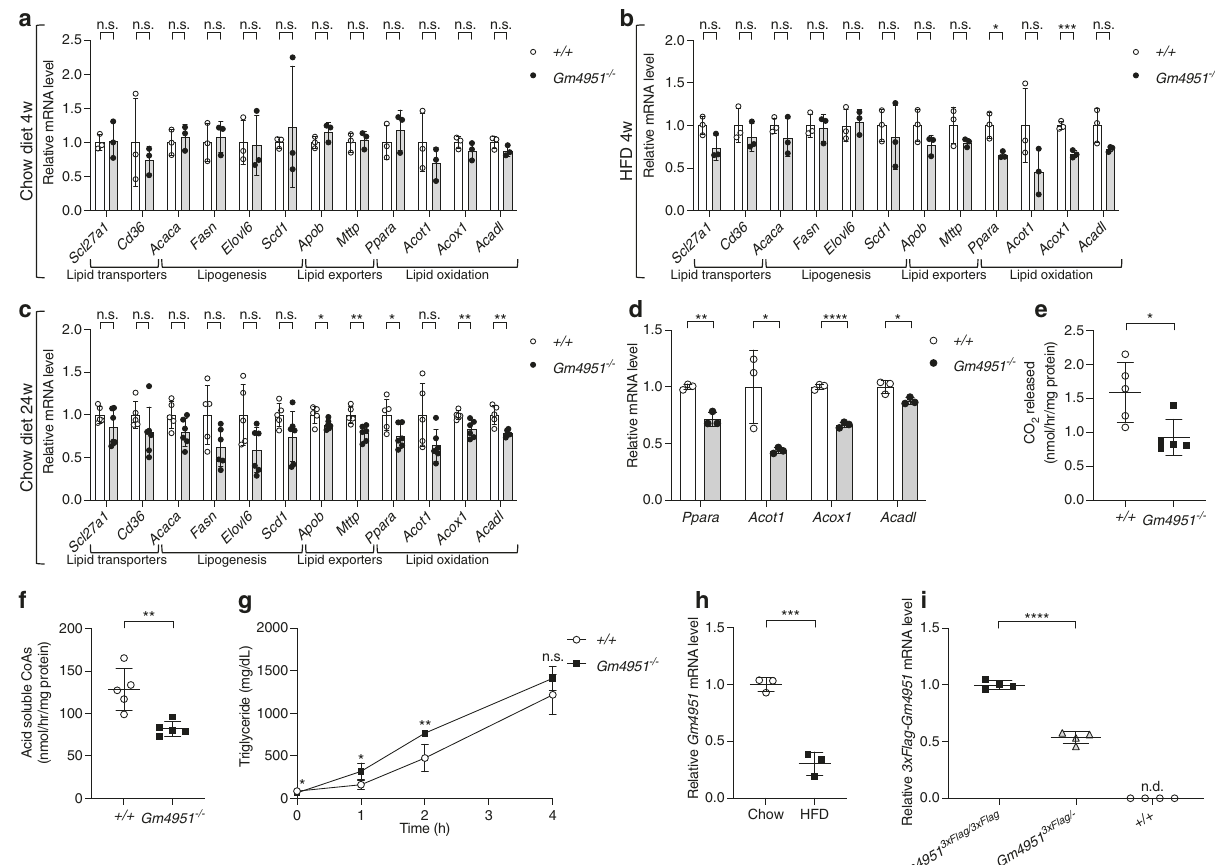
Fig. 5 GM4951 is involved in lipid oxidation and is downregulated by HFD feeding. a - c Relative mRNA level of different genes in the liver from WT and Gm4951 − / − mice on chow diet ( a ) and HFD ( b ) for four weeks ( n = 3 mice per genotype), and chow diet for 24 weeks ( c ) ( n = 5 mice per genotype). Levels were normalized to Polr2a mRNA and then to levels in WT mice. d Relative mRNA level of different genes in hepatocytes from WT and Gm4951 − / − mice after 0.5 mM OA for 24 h ( n = 3 mice per genotype). e , f CO 2 released ( e ) and acid soluble CoAs ( f ) from fatty acid oxidation experiment were measured with scintillation counting and normalized with total protein of liver lysates ( n = 5 mice per genotype). g The serum level of triglycerides at different time points after Triton WR-1399 injection in WT and Gm4951 − / − mice on HFD for 4 weeks ( n = 3 mice per genotype). h Relative mRNA level of Gm4951 in the liver from C57BL6/J mice on chow diet or HFD for 24 weeks ( n = 3 mice per genotype). Levels were normalized to Polr2a mRNA and then to levels in WT mice fed chow diet. i Relative mRNA level of 3xFlag-Gm4951 in the liver from mice of the indicated genotypes on chow diet at eight weeks of age ( n = 4 mice per genotype). n.d. not detected. Levels were normalized to Polr2a mRNA and then to levels in WT mice. Each data point represents one mouse ( a – f , h – i ). Data are presented as means± SD. P values were determined by two-tailed Student ’ s t test. P values are denoted by * P < 0.05; ** P < 0.01; *** P < 0.001; **** P < 0.001; ns, not signi fi cant with P > 0.05. The exact P values of statistically signi fi cant groups are: 0.0176 ( b , Ppara ); 0.0009 ( b , Acox1 ); 0.0418 ( c , Apob ); 0.0041 ( c , Mttp ); 0.0281 ( c , Ppara ); 0.0017 ( d , Ppara ); 0.0401 ( d , Acot1 ); 8.466 × 10 − 5 ( d , Acox1 ); 0.0288 ( d , Acadl ); 0.0201 ( e ); 0.0039 ( f ); 0.0116 ( g , 0 h); 0.0132 ( g , 1 h); 0.0040 ( g , 2 h); 0.0005 ( h ); 6.292 × 10 − 6 ( i ). Data are representative of two independent experiments ( a – d , g – i ) or from one experiment ( e – f ).